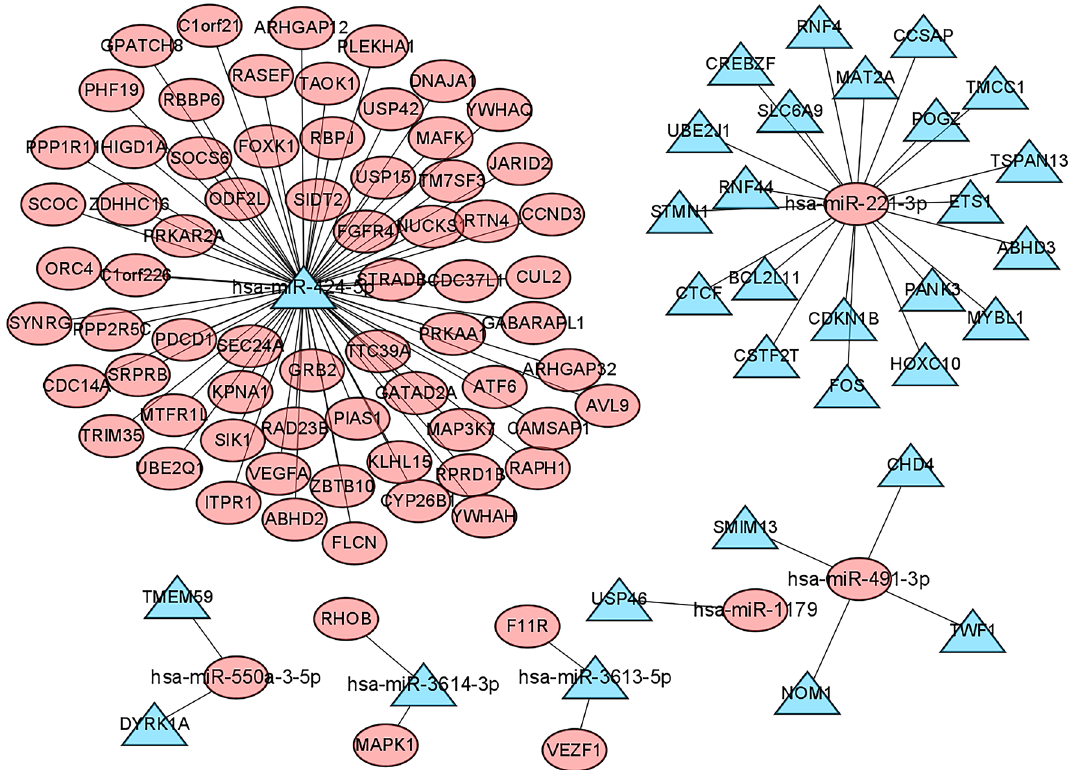
Figure 10. miRNA–mRNA network. Red denoted up-regulated; blue denoted